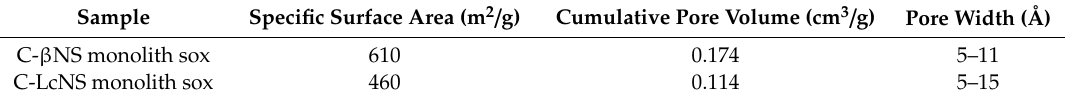
Figure 8. TGA of β NS ( a ) and LcNS ( b ). Table 6. Specific surface area, cumulative pore volume, and pore width of the C- β NS .